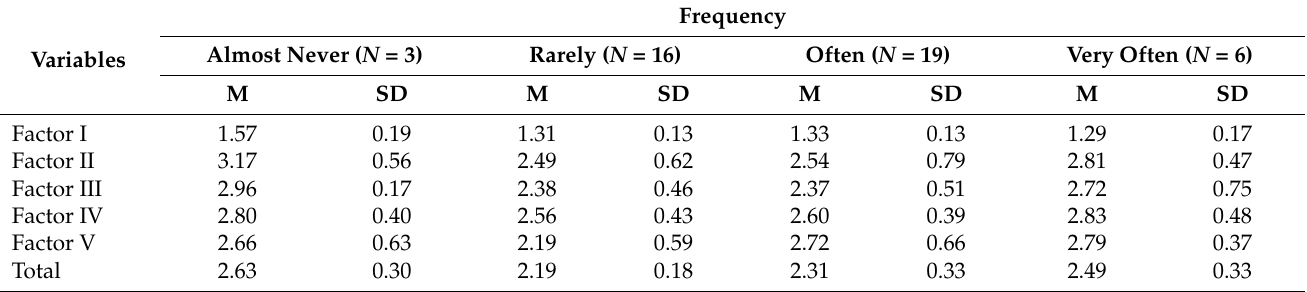
Table 8. Mean and standard deviation of perceptions of attention to diversity based on frequency of contact.